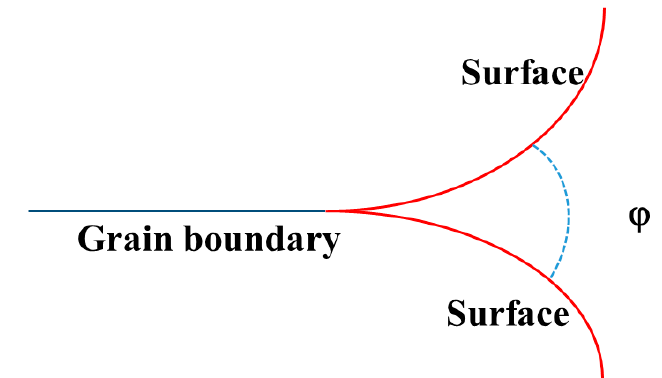
Figure 7. Diagram of two balanced surfaces and a grain boundary.